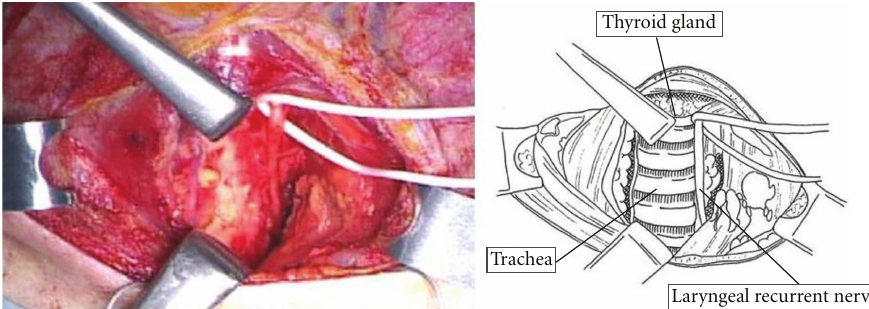
Figure 2: Dissection of left cervical paraesophageal lymph nodes. Left laryngeal recurrent nerve was taped.